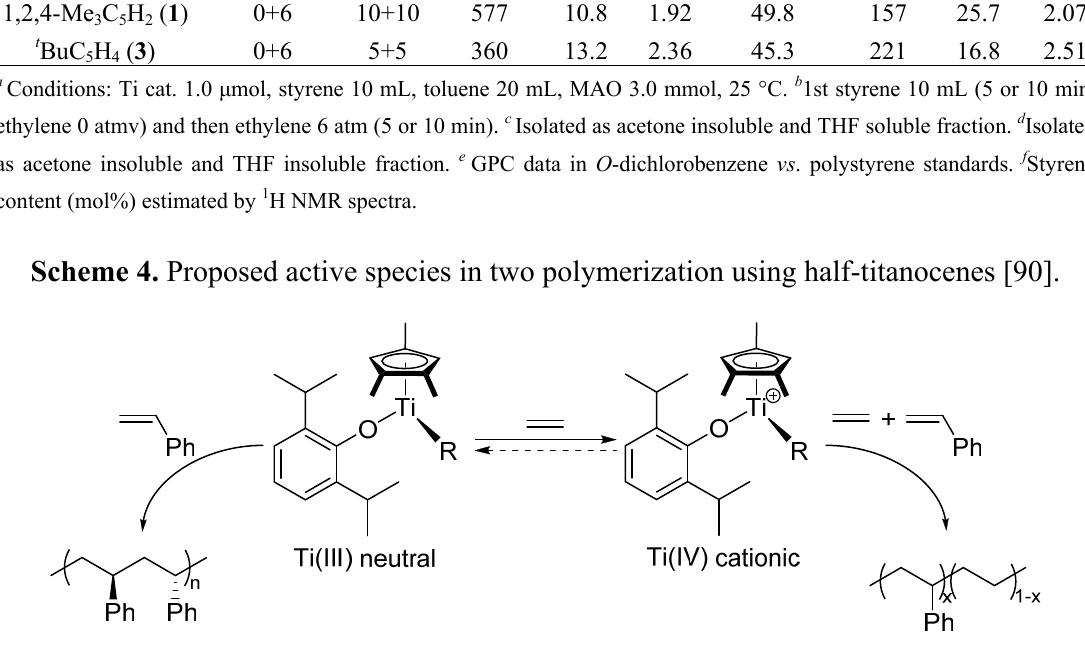
Table 4. Two step ethylene/styrene (co)polymerization by Cp ' TiCl